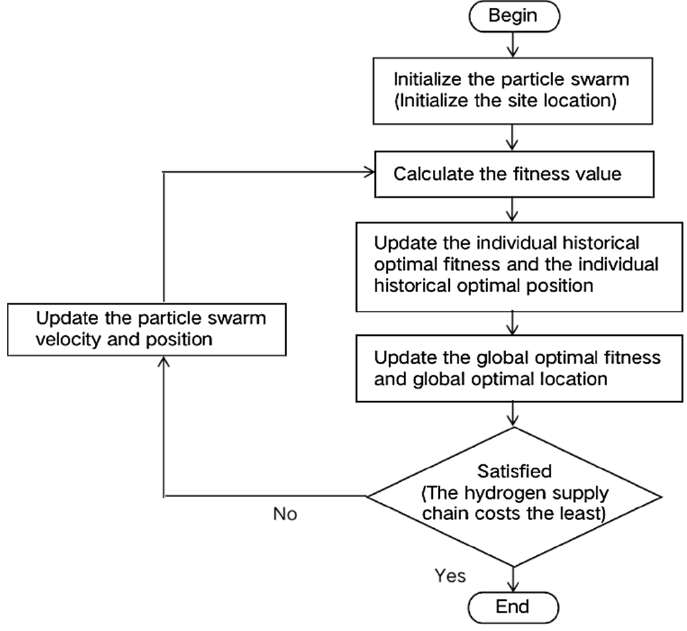
Figure 8. Flow chart of the PSO calculation process.